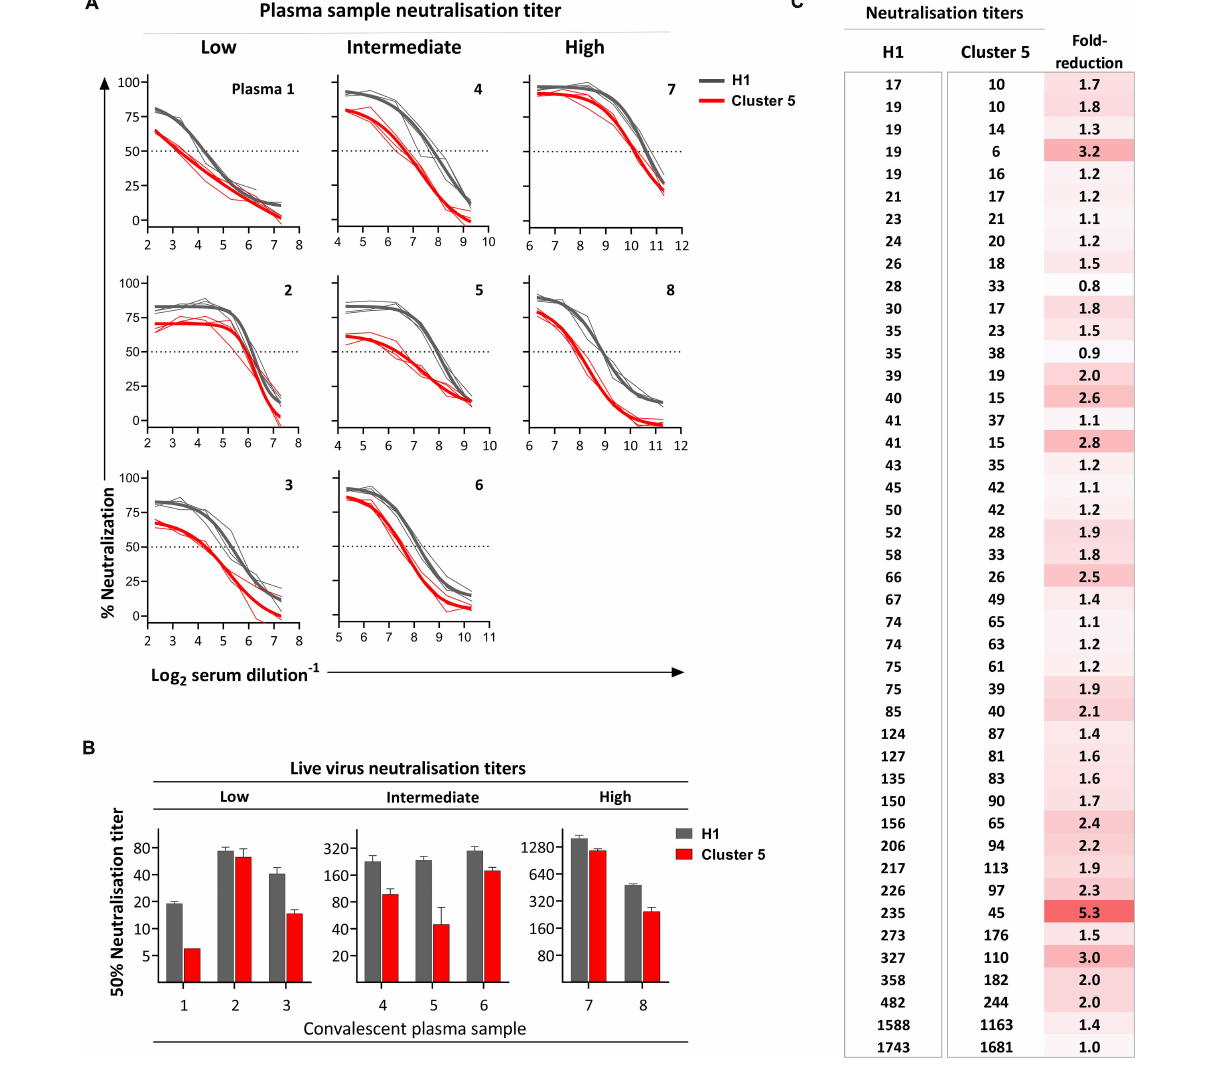
in the spike protein ( (cid:49) H69/V70, Y453F, I692V, and M1229I) in addition to